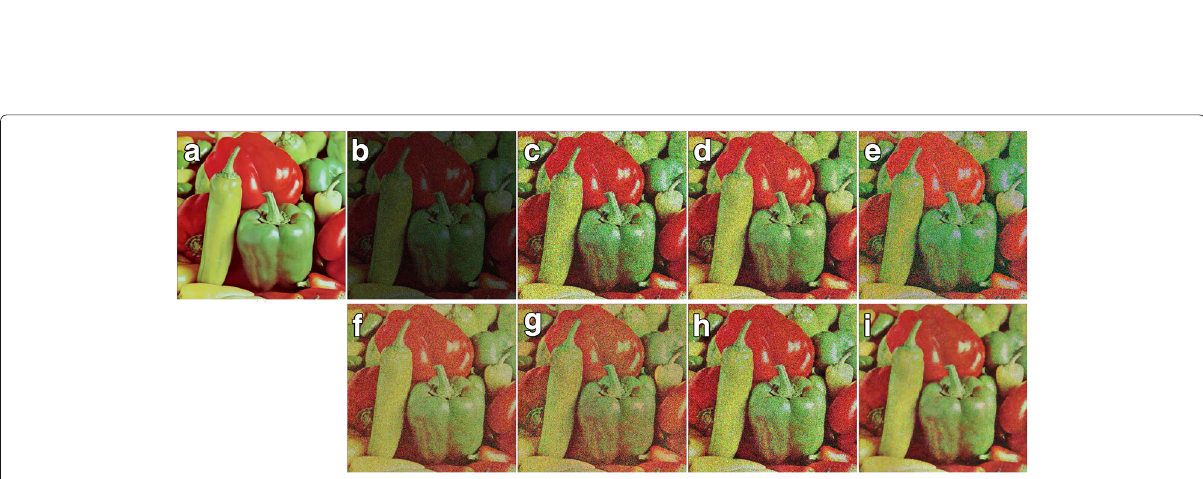
Fig. 8 Comparative results using simulated low-light image with σ = 20: a input image, b simulated low-light image, c Chen’s method [2], d Kim’s method [3], e Jiang’s method [8], f Ravi’s method [23], g Jobson’s method [14], h Fu’s method [16], and i the proposed method ( λ 1 = 300, λ 2 = 0.2, = 0.9, and ω = λ 3